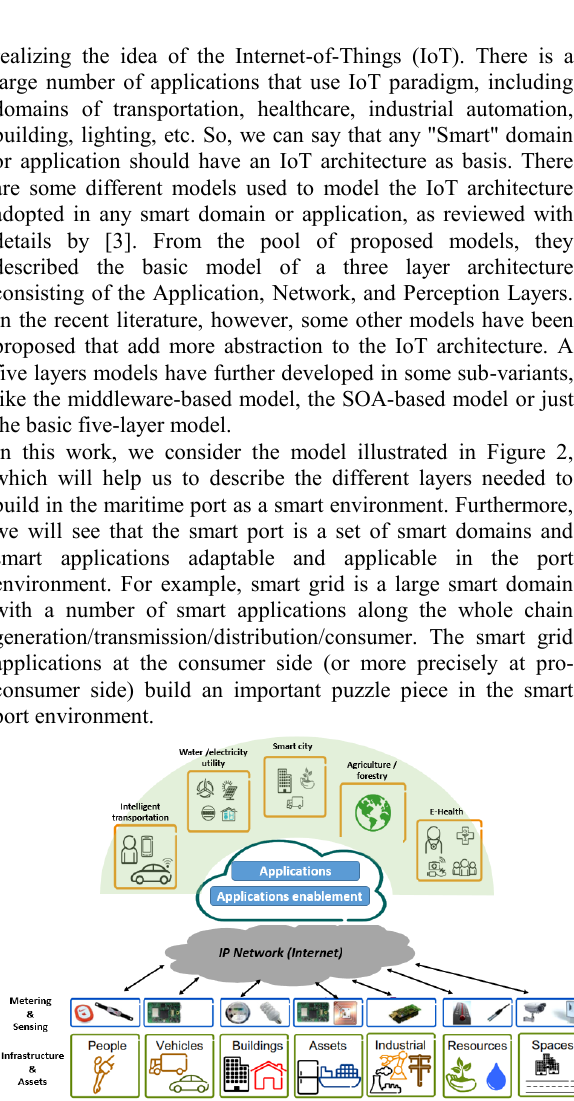
Figure 2 . Network layer as core layer in different vertical smart